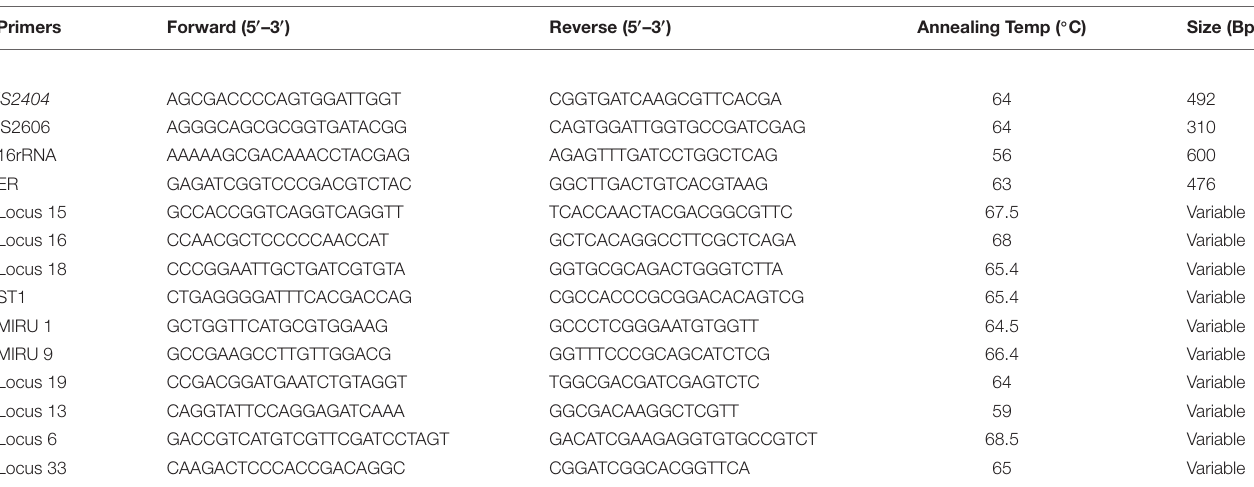
TABLE 1 | Primers used for genotyping of M. ulcerans from clinical and environmental